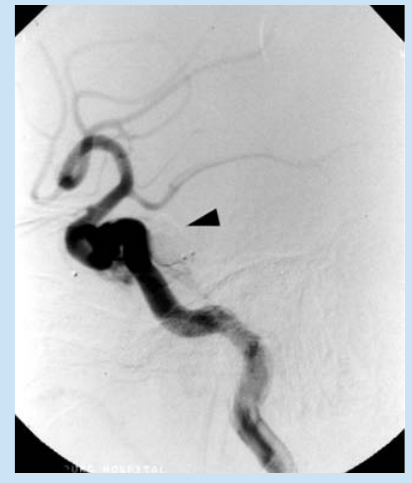
Fig. 4b. Lateral internal carotid angiogram follow- ing placement of single balloon (arrow) via the infe- rior petrosal sinus, closing the fistula with preser- vation of the internal carotid artery.